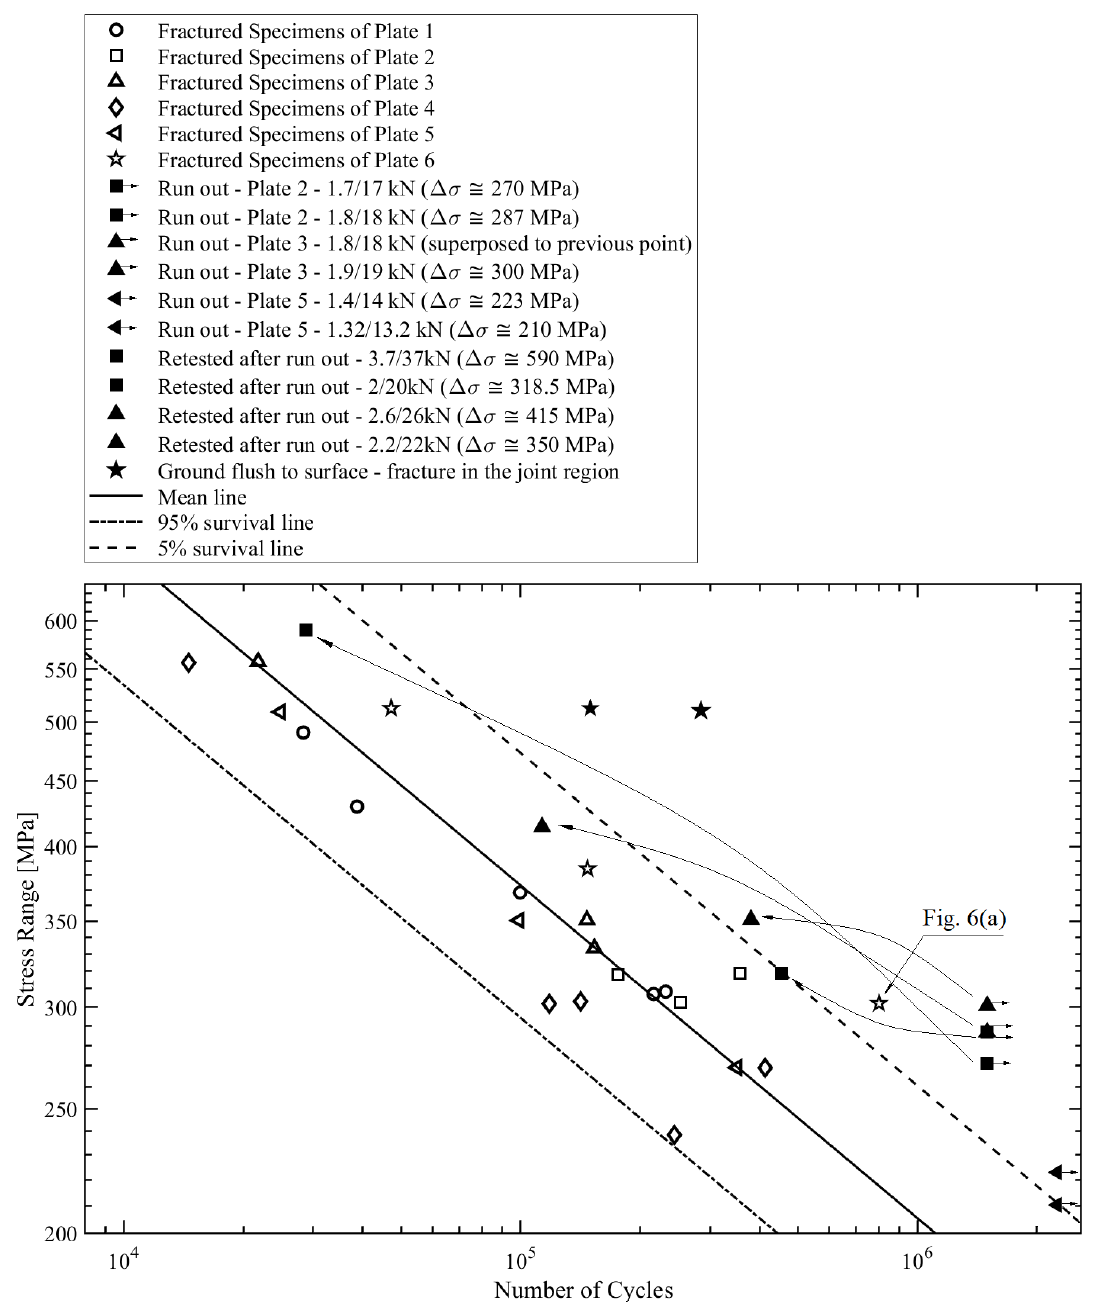
Figure 3. S – N diagram of laser-welded NbMo modified 22MnB5 steel. Figure 3. S–N diagram of laser-welded NbMo modified 22MnB5